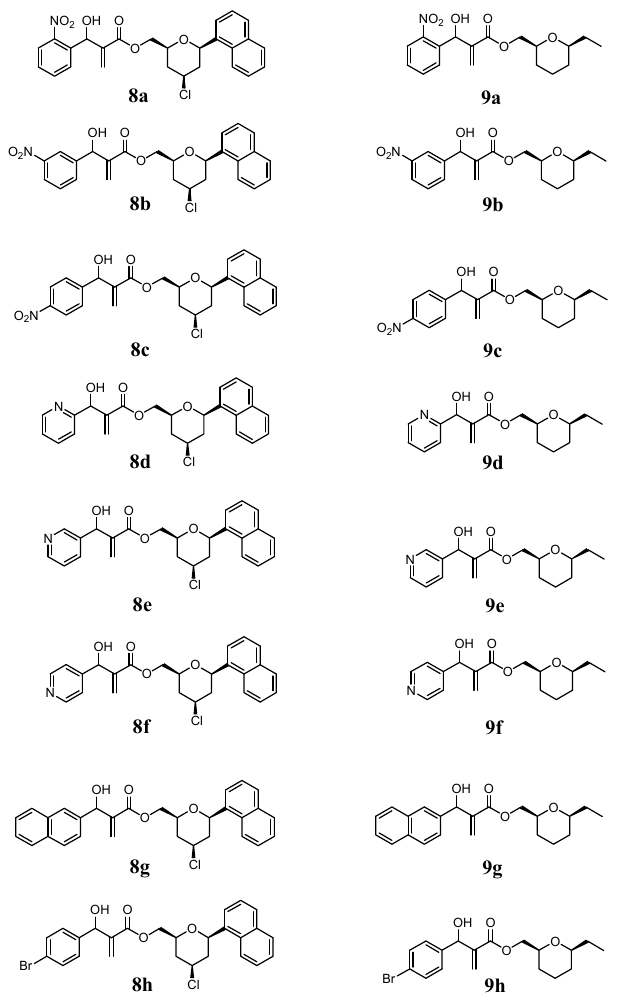
Figure 2. The synthetized hybrids 8a – 8h and 9a – 9h .